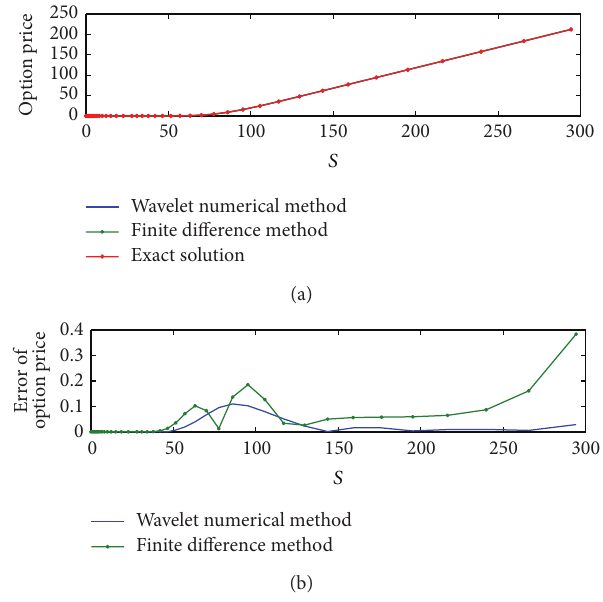
Figure 6: Comparison between the wavelet sparse grid approach and the finite difference